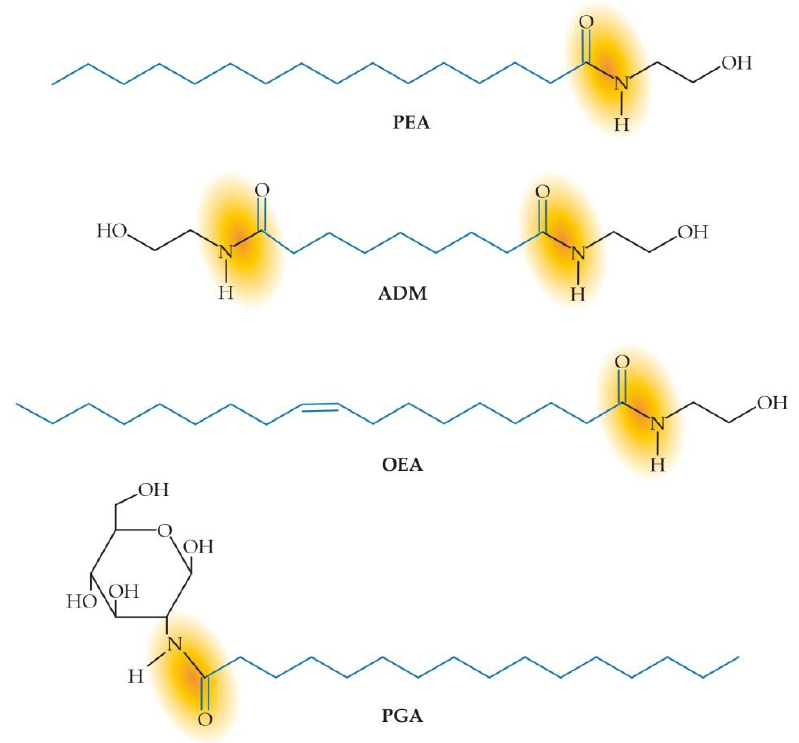
Figure 2. Chemical structure of the main ALIAmides. The amide bond (yellow shadow) and the fatty acid (blue color) are highlighted. ADM = Adelmidrol, OEA = oleoylethanolamide, PEA = palmitoylethanolamide, PGA = palmitoylglucosamine.